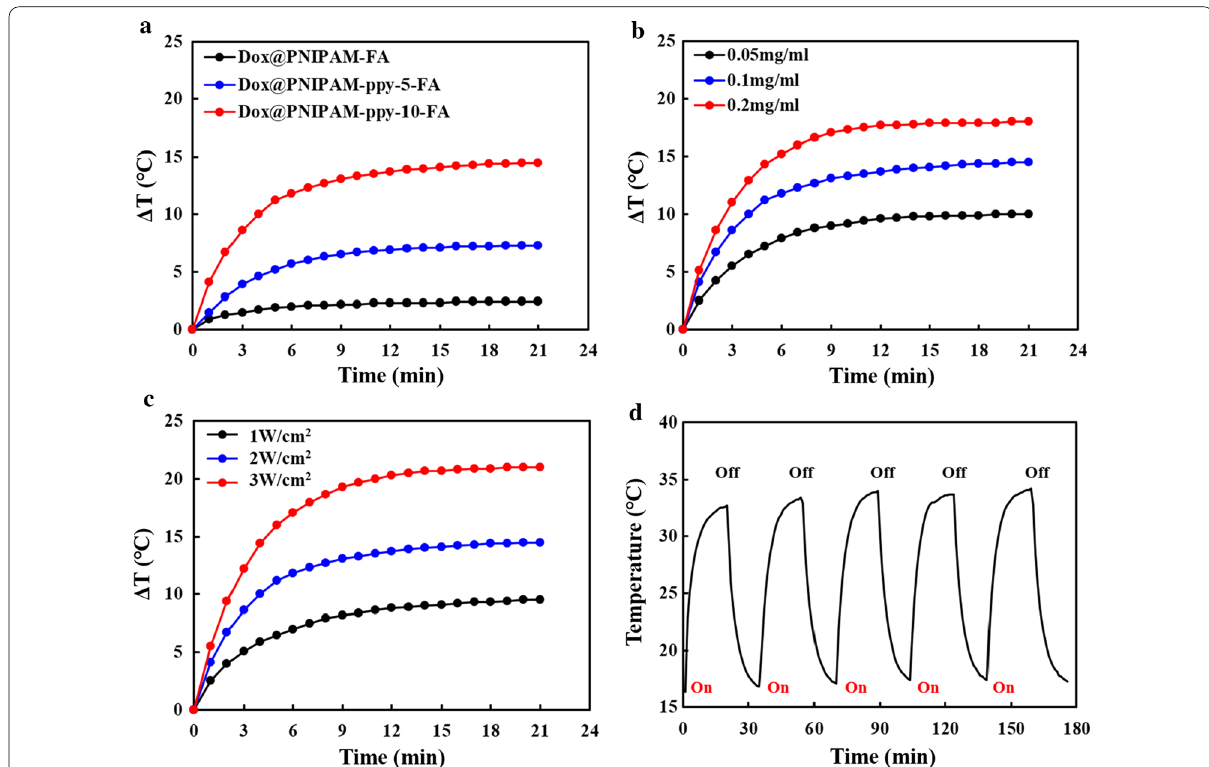
Fig. 3 Photothermal performance of PNIPAM-ppy-FA nanocomposites. a Temperature analysis of Dox@PNIPAM-ppy-5-FA and Dox@ PNIPAM-ppy-10-FA under 808 nm NIR laser irradiation (2 W/cm 2 ). b Temperature analysis of different concentration of Dox@PNIPAM-ppy-FA under 808 nm NIR irradiation (2 W/cm 2 ). c Photothermal effect of Dox@PNIPAM-ppy-FA with various power densities (1, 2, and 3 W/cm 2 ). (D) Temperature curve of Dox@PNIPAM-ppy-FA over five on/off cycles using NIR laser irradiation (2 W/cm 2